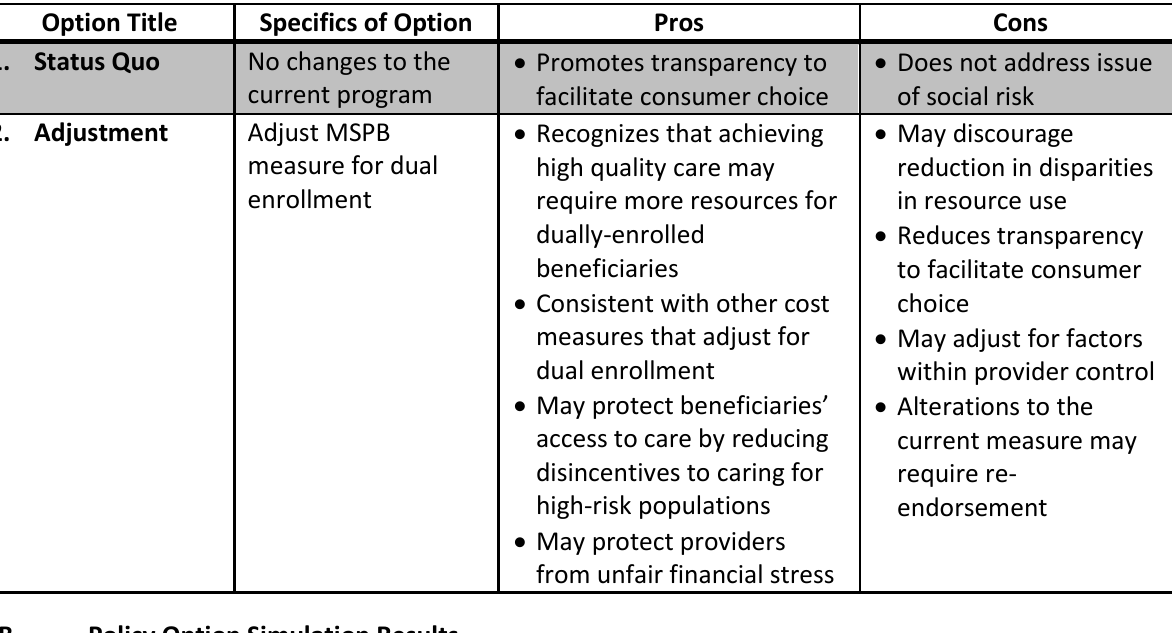
Table 7.12. Summary of Policy